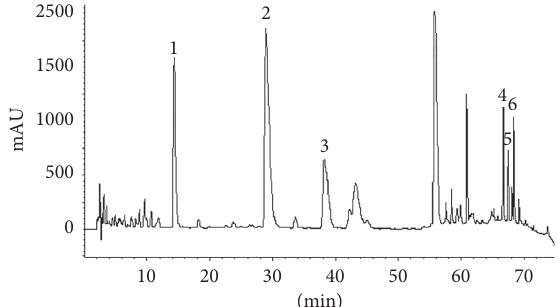
Figure 1: HPLC chromatogram of RDN injection. 1: neo- chlorogenic acid; 2: chlorogenic acid; 3: cryptochlorogenic acid; 4: isochlorogenic acid B; 5: isochlorogenic acid A; and 6: iso- chlorogenic acid C.